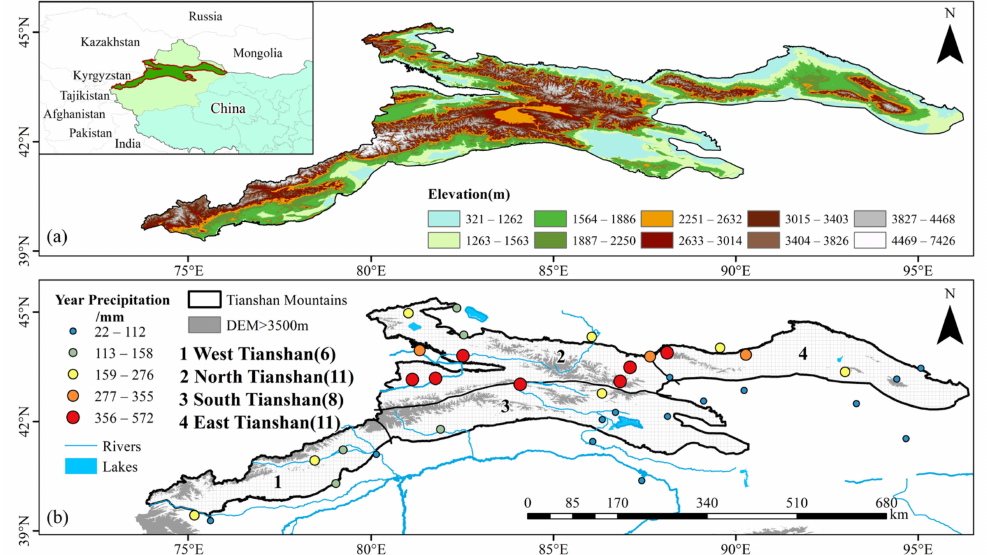
Figure 1. ( a ) Geographical location and Extent and topography of the Tianshan Mountains; ( b ) Boundary of sub–regions, location of stations and their annual precipitation. The number of stations considered for each region: West: 6; North: 11; South: 8; East: